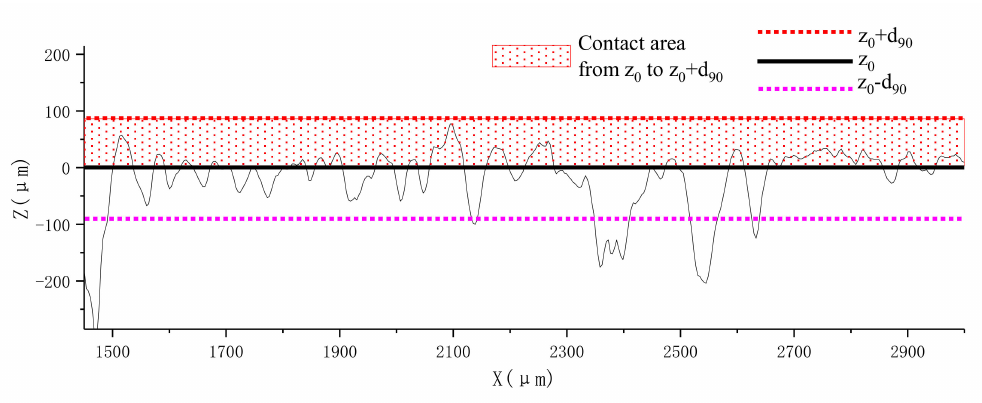
Figure 10. Real contact region located in the 2D profile.